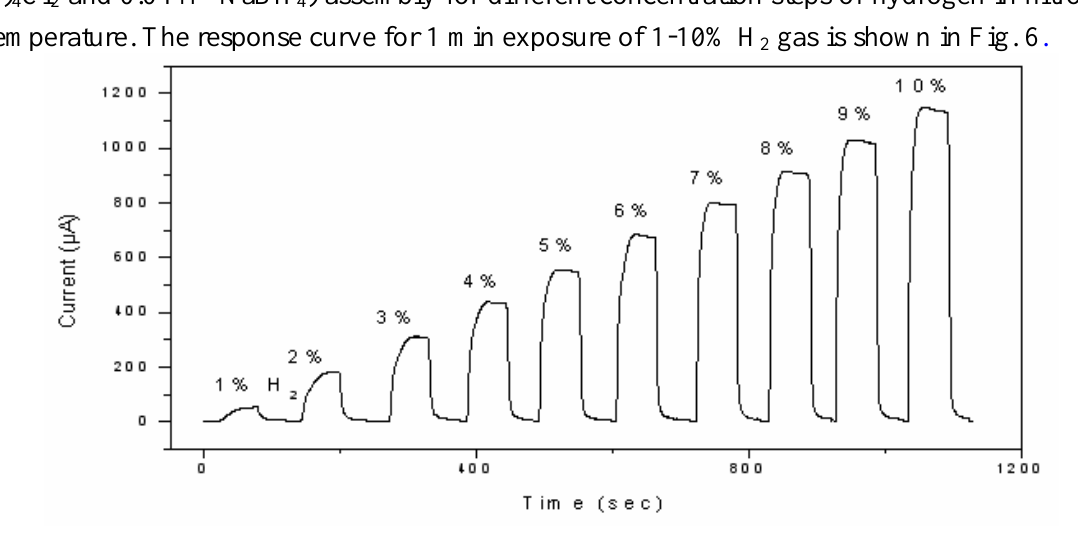
) Cl and 0.04 M NaBH (sample N4) for hydrogen gas in the low 3 4 2 4